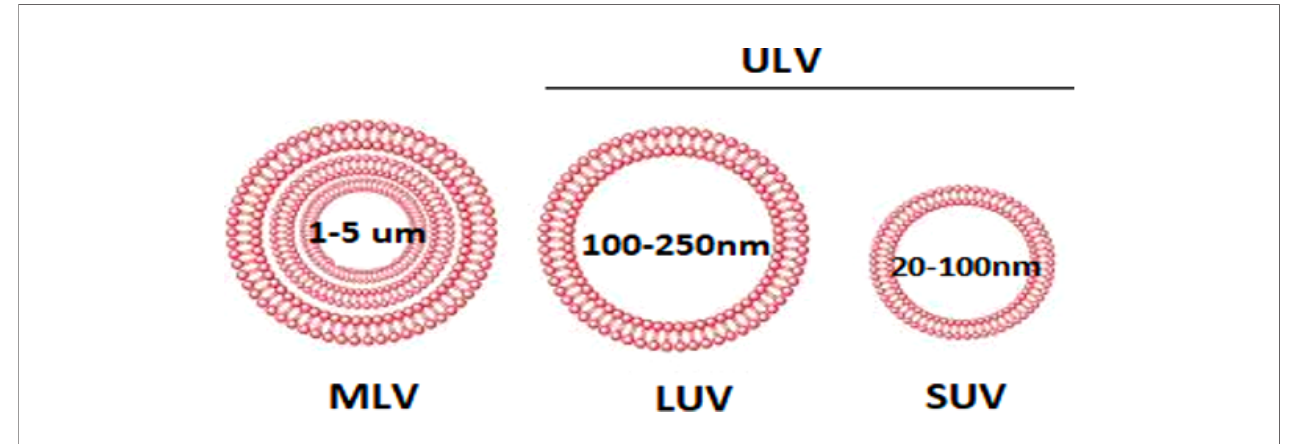
FIGURE 2 | Classi fi cation of liposomes based on lamellarity.